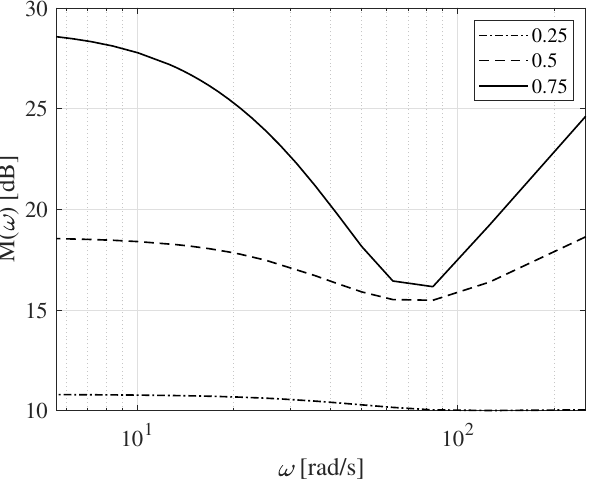
Figure 9. The analytical Bode diagrams were obtained using (12).